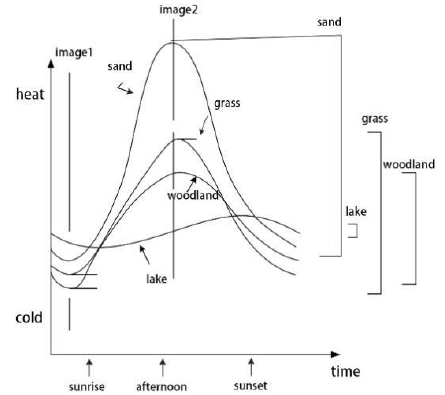
Figure 4. Drought monitoring results based on the percentage of precipitation anomalies in the study in March 2016 in Donglei Irrigation District (Phase Ⅱ )